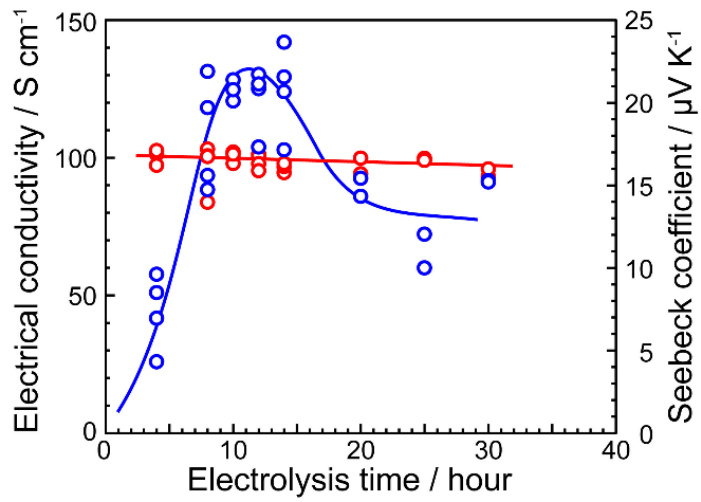
Figure 10. Thermoelectric properties of erGO/PAn composites prepared by various electrolysis times.